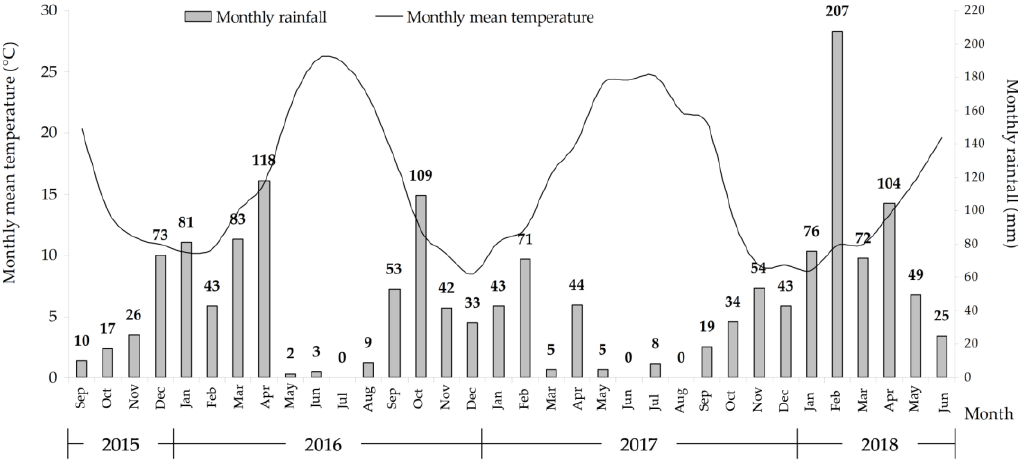
Figure 2. Thermo-pluviometric diagram of the Mitra meteorological station between September 2015 and June 2018.